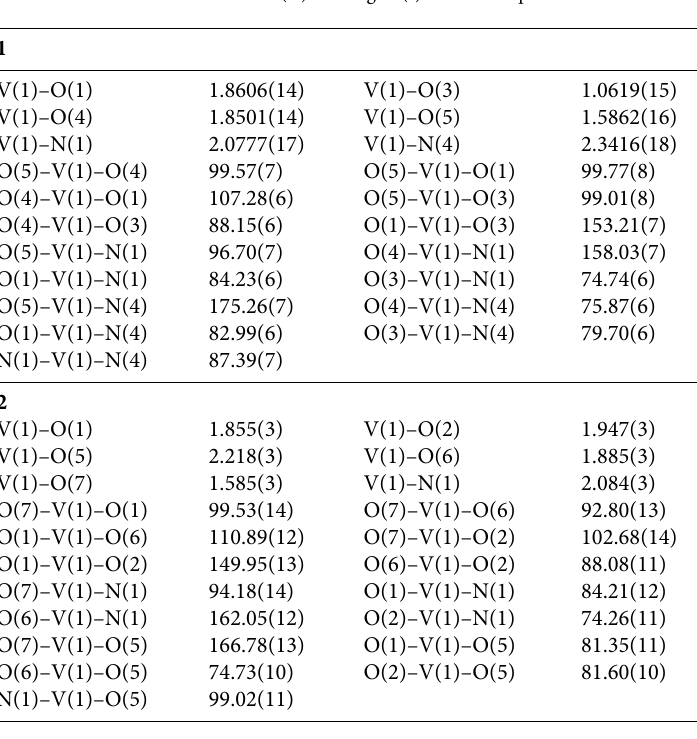
Figure 1. ORTEP plot of the molecular structure of complex 1 . Dis- Figure 2. ORTEP plot of the molecular structure of complex 2 . Dis- placement ellipsoids of non-hydrogen atoms are drawn at the 30% placement ellipsoids of non-hydrogen atoms are drawn at the 30% probability level. probability Table 2. Selected bond distances (Å) and angles (º) for the complexes.